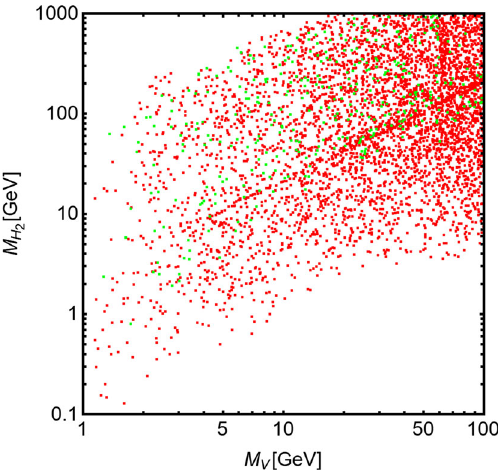
Fig. 21 ThesameasFig.11butforthedarkSU(3)modelintheregime ] plane, Vp M Ψ < M V , V 3 and Ψ not stable with respect the age of the